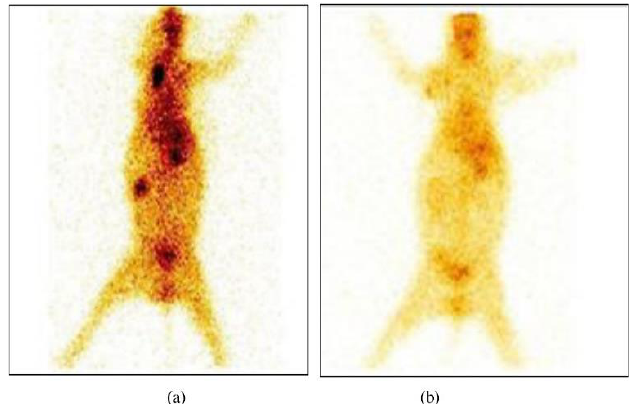
Figure 4. Gamma scintigraphy images after intranasal administration (6 h) of ( a ) DLX-NLC suspen- sion, ( b ) DLX solution. These images show the localization of DLX in different organs, including brain of rabbit. DLX-NLC exhibited better localization than DLX. Adapted with permission from [47], Elsevier, 2014.